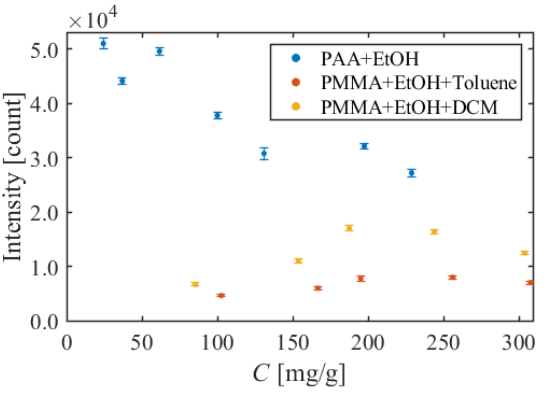
Figure 11. Comparison of luminescent intensity in different dye concentrations and formulations.